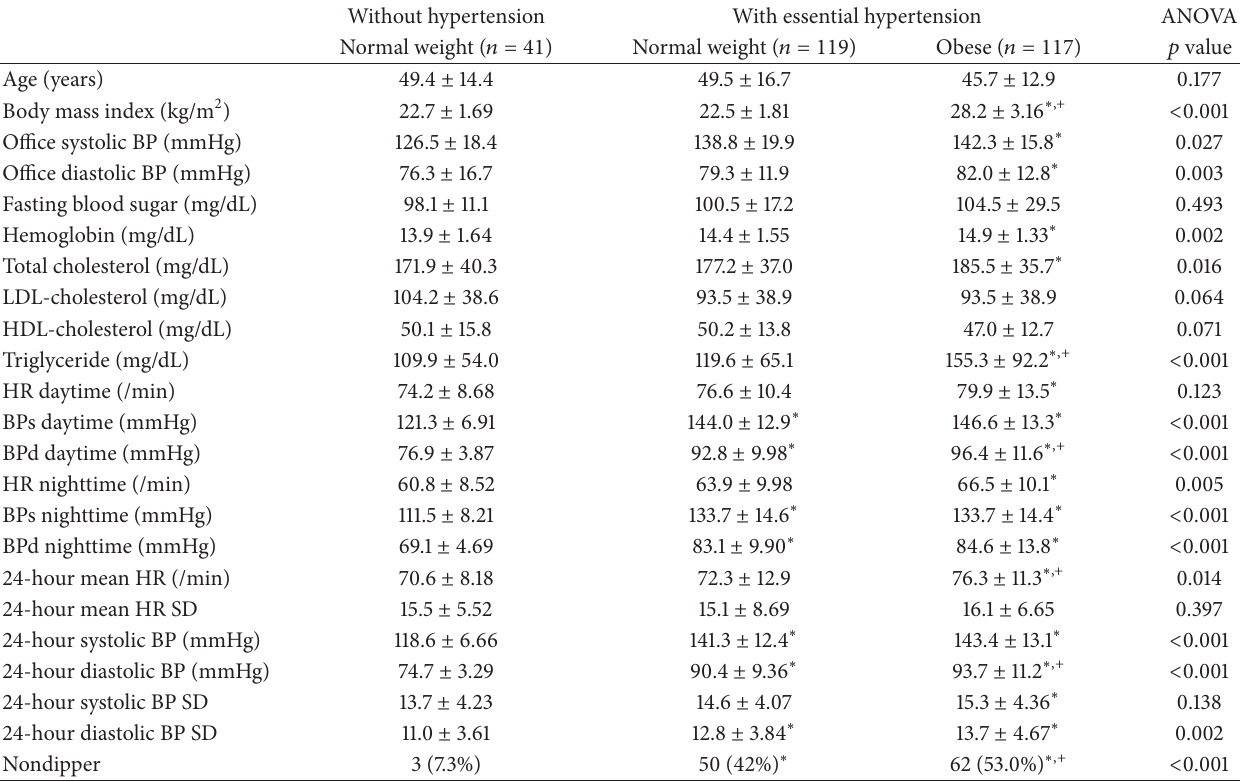
Table 1: The clinical characteristics and ambulatory blood pressure measurements of the study population in